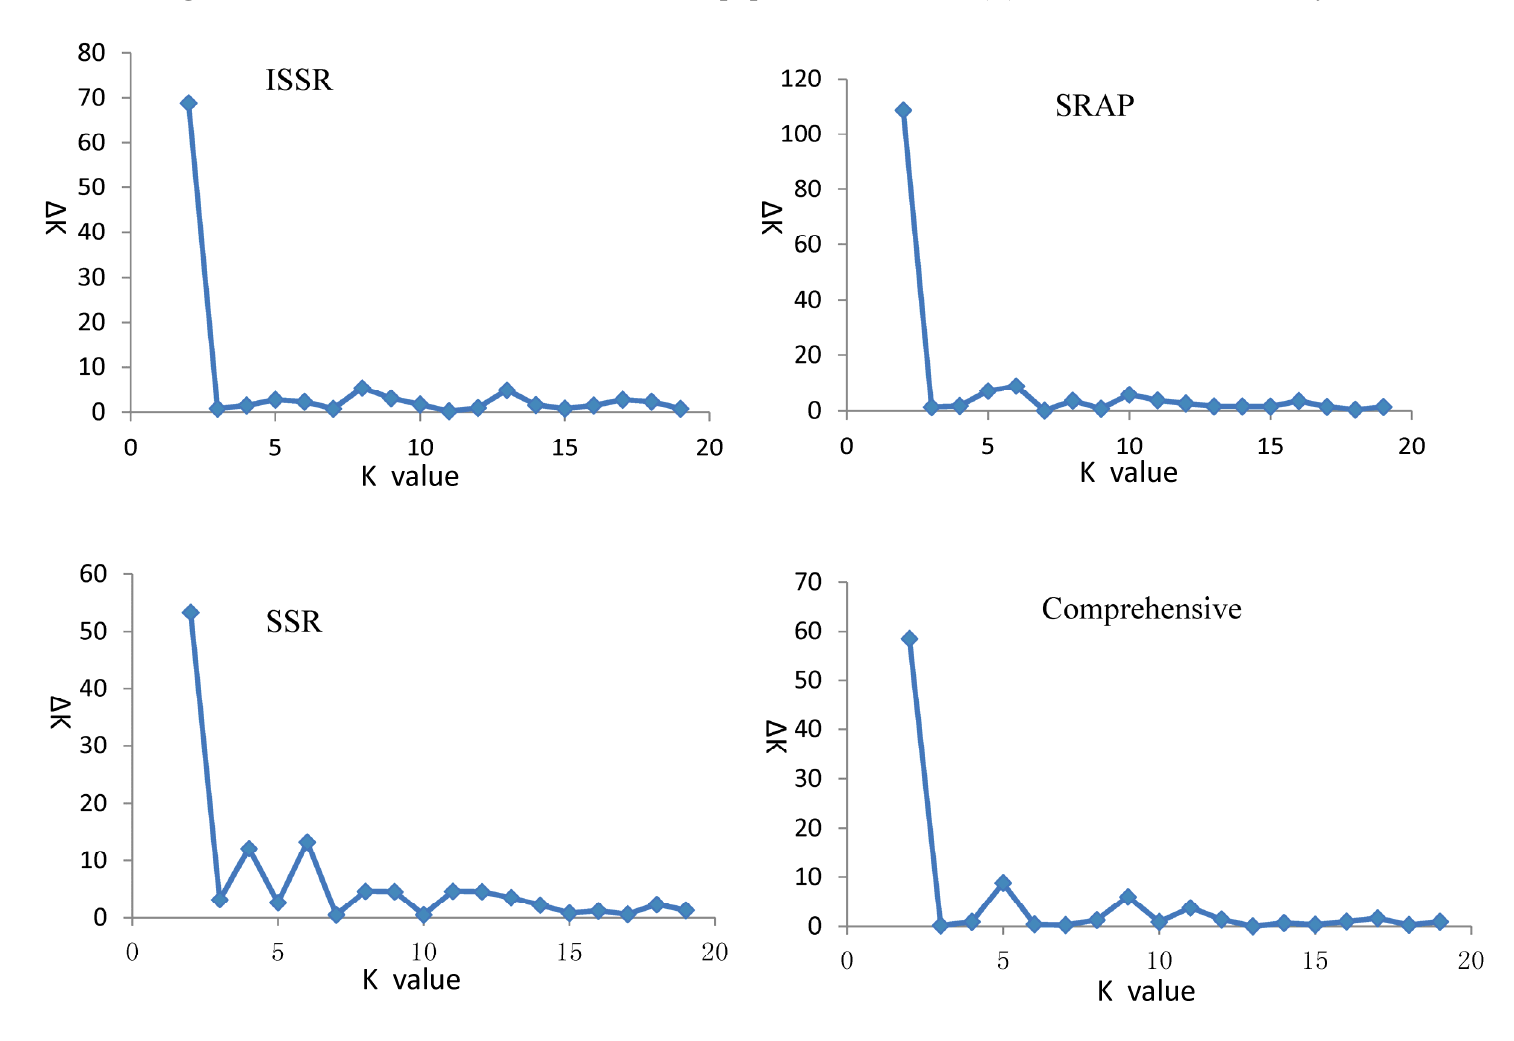
Figure S1. ∆ K values for different numbers of populations assumed ( K ) in the STRUCURE